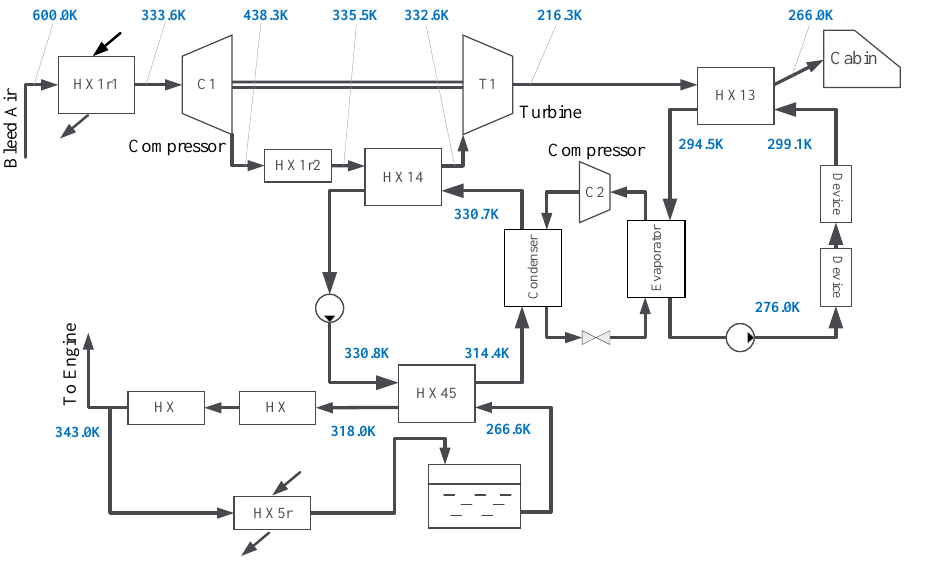
Figure 6. Temperature results under cruise